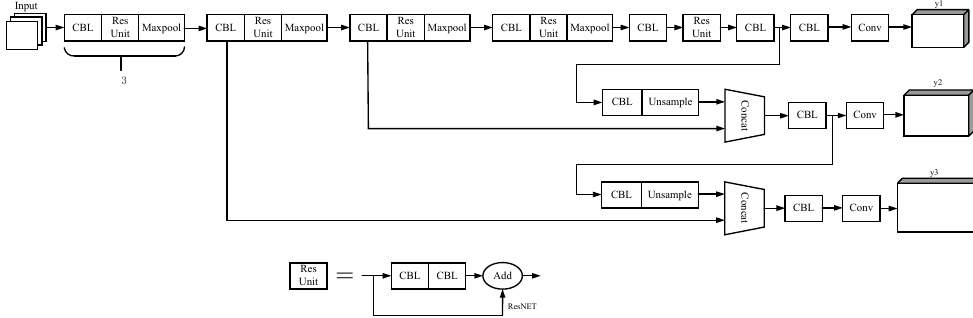
Figure 3. Improved YOLO v3-tiny network structure diagram.